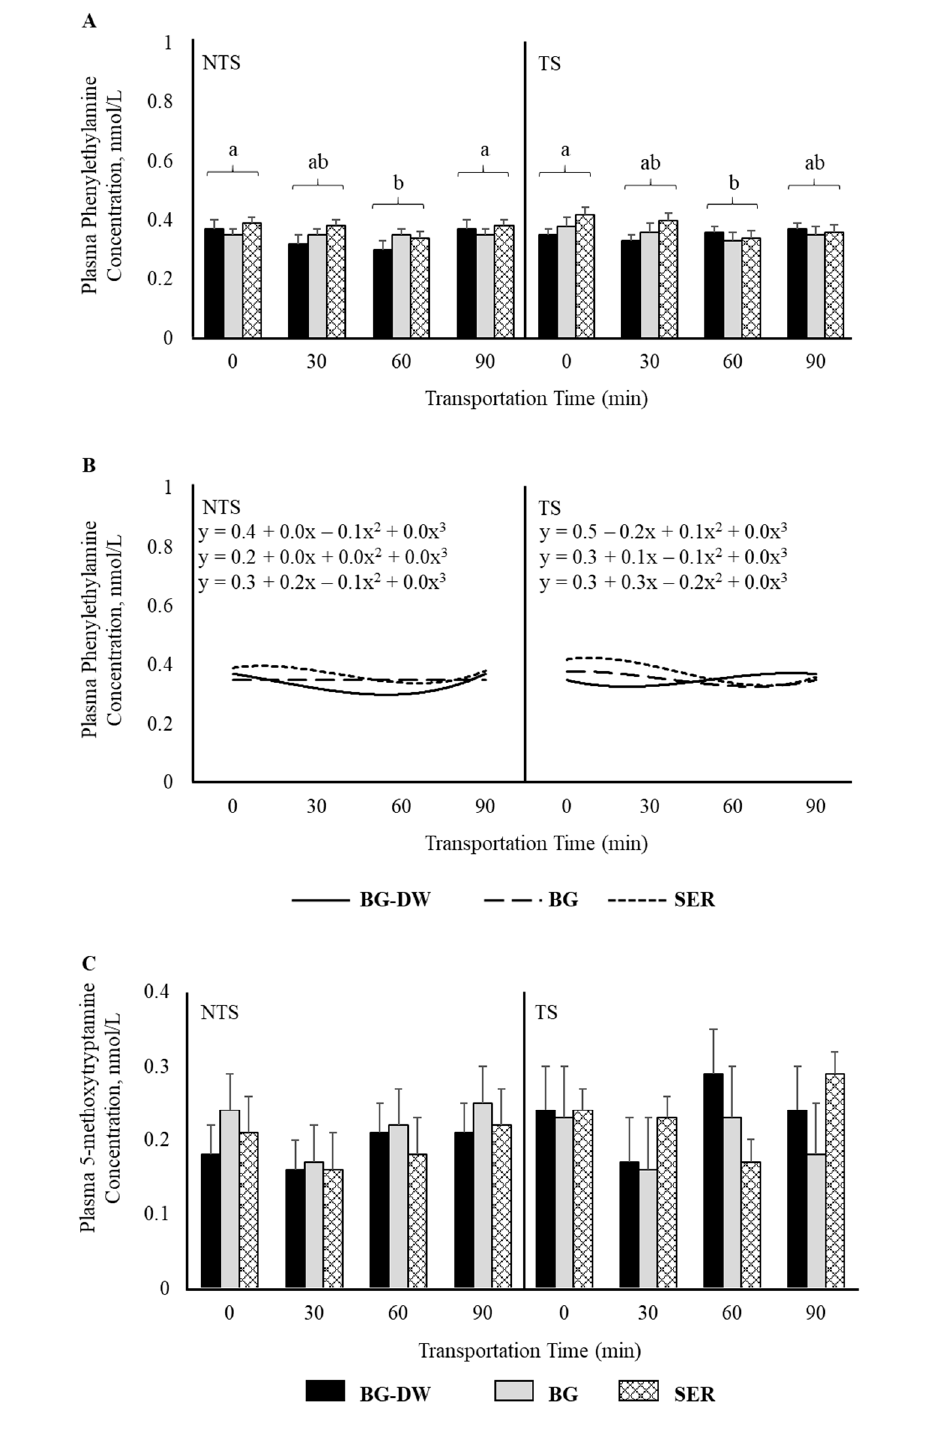
Figure 6. ( A ) Effects of Diet (BG-DW: bermudagrass hay—dewormed; BG: bermudagrass hay; SER: sericea hay), Stress Treatment (ST; NTS: non-transported; TS: transported), and Time (Time, p < 0.01) on plasma phenylethylamine concentrations in goats. ( B ) Polynomial contrasts showing a significant cubic trend ( p < 0.05) over Time. ( C ) Plasma 5-methoxytryptamine concentrations in goats. Bars represent means with SEM. Pearson correlation analysis (Table 2) between cortisol and selected biogenic